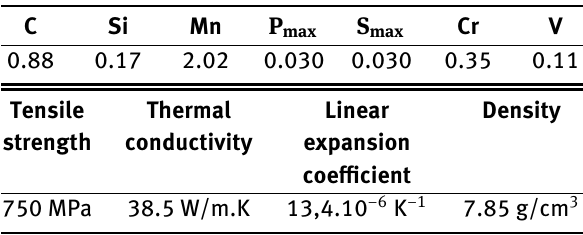
Table 1: Chemical composition of tool steel (wt%) and it’s physical and mechanical